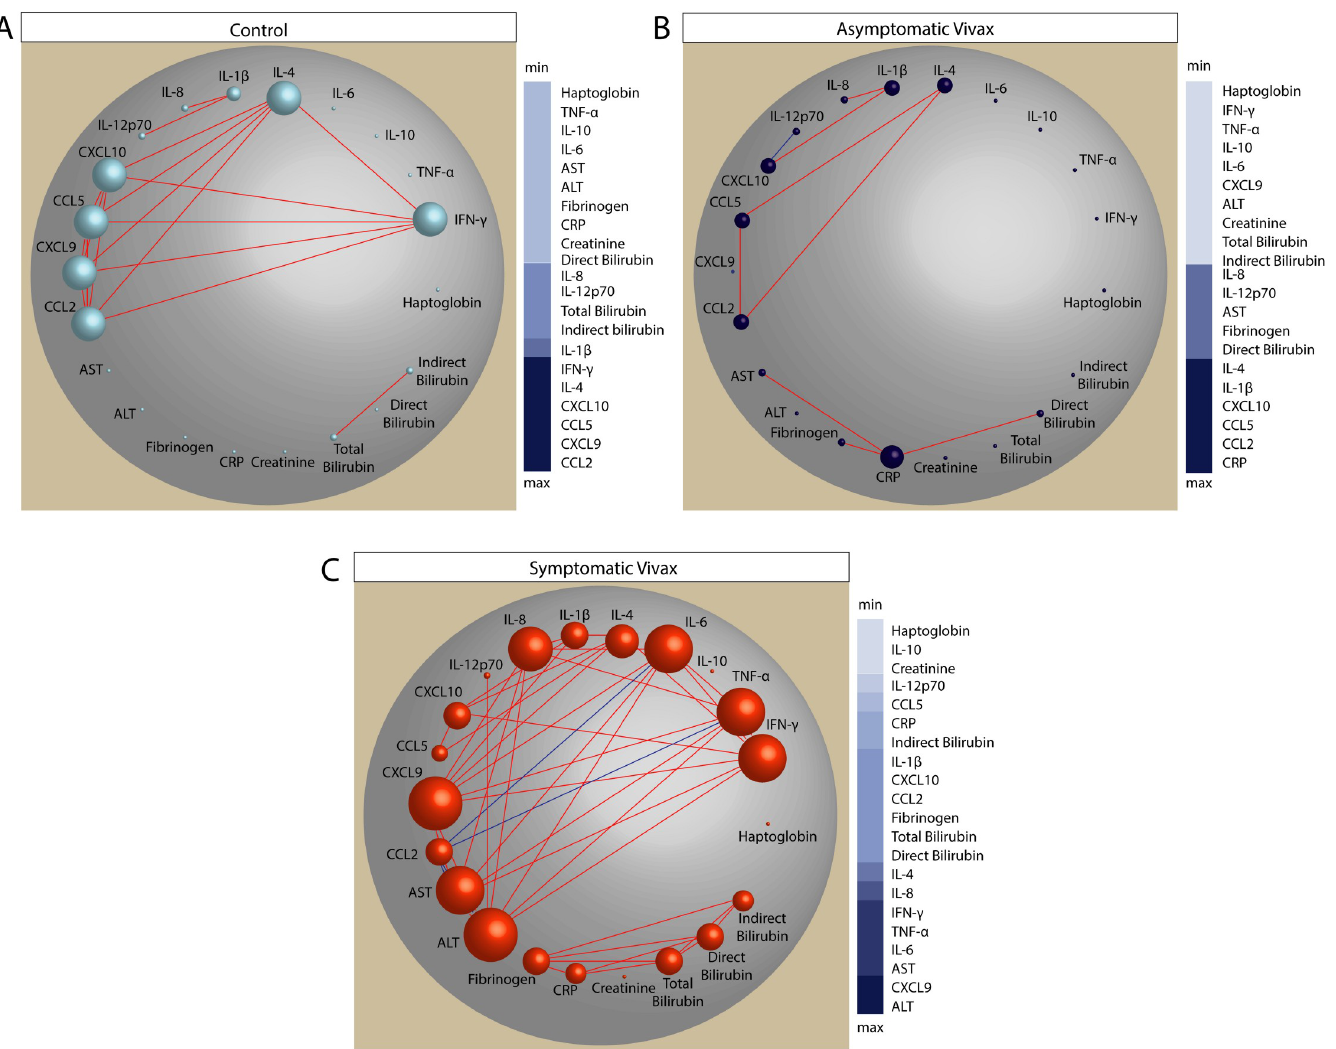
Fig 2. Network analysis of the MDP score values in the study groups. Spearman correlation matrices of the MDP score values in each study group—(A) controls; (B), asymptomatic vivax malaria; (C) symptomatic vivax malaria—were built and Circus plots were used to illustrate the correlation networks. Only significant correlations (p < 0.05 after adjustment for multiple comparisons) are shown. Each circle represents a different plasma parameter, and the size of each circle is proportional to the number of significant correlations. Lines represent the Spearman rank (rho) values. Red color infers positive correlation, whereas blue color denotes negative correlation. Node analysis heatmap shows the number of statistically significant correlations involving each marker per clinical group. Abbreviations (alphabetic order): ALT: alanine aminotransferase; AST: aspartate aminotransferase; CCL: C-C motif chemokine ligand; CXCL: C-X-C motif chemokine ligand; CRP: C-reactive protein; IFN: interferon; IL: interleukin; TNF: tumor necrosis